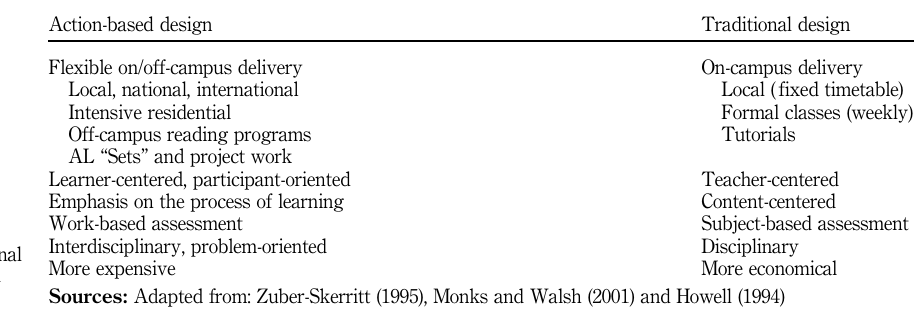
based and traditional executive program